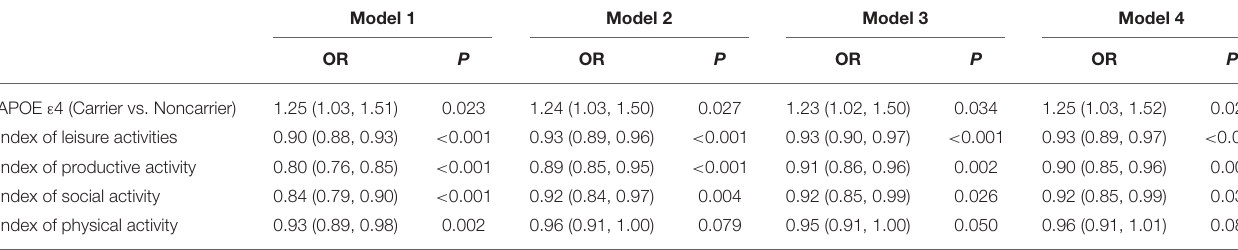
TABLE 2 | Association of APOE ε 4, Index of leisure activities (ILA), and subtypes of leisure activity with a cognitive decline between 2008 and 2014.